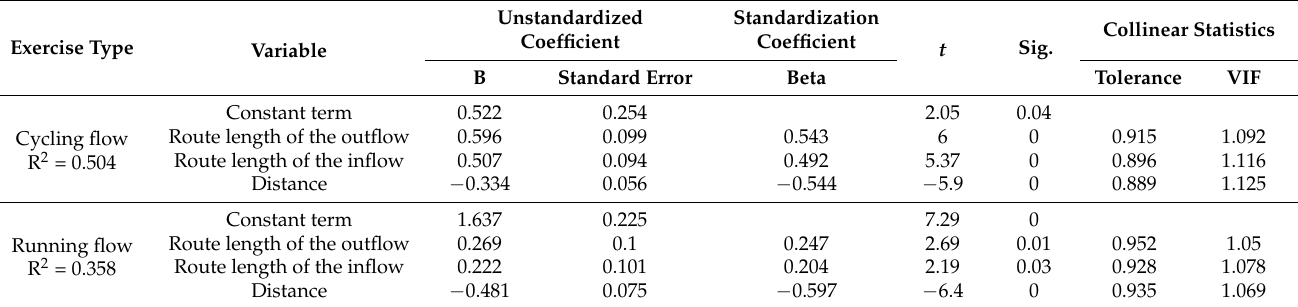
Table 6. Multiple linear regression fitting of the cycling and running